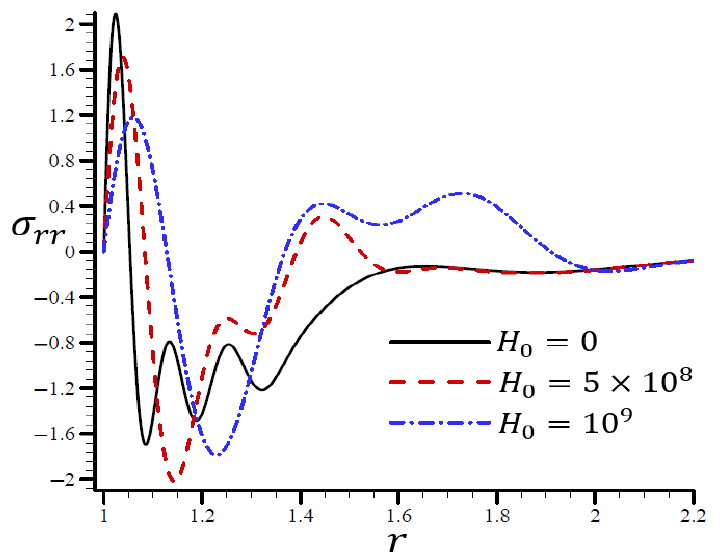
Figure 15. The influence of H 0 on radial stress σ rr through the radial direction of the spherical hole using the RTPL model.